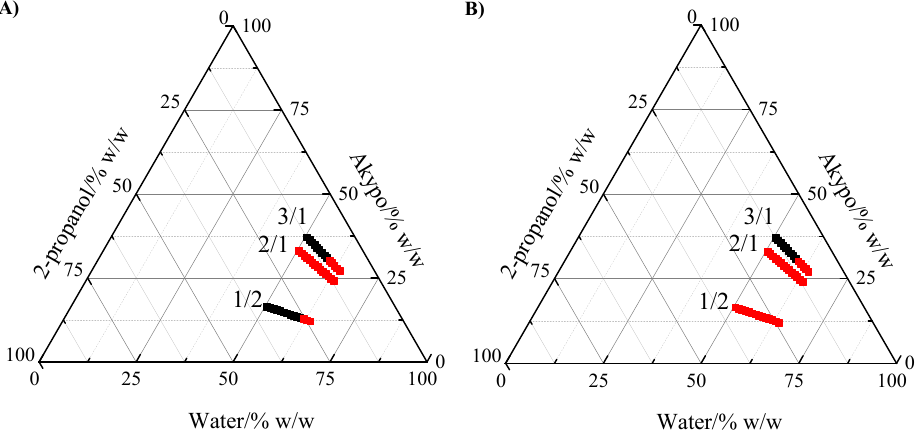
Figure 2. Cuts of the pseudo-ternary phase diagram corresponding to a fixed oil concentration (3% w / w ) showing the explored compositional lines of fixed surfactant/co-surfactant ratio (indicated in the diagrams) where the compositions corresponding to O/W microemulsions ( ■ ) and phase-separated systems ( ■ ) are indicated with different colors. ( A ) Mixtures containing oleic acid. ( B ) Mixtures containing soybean oil.